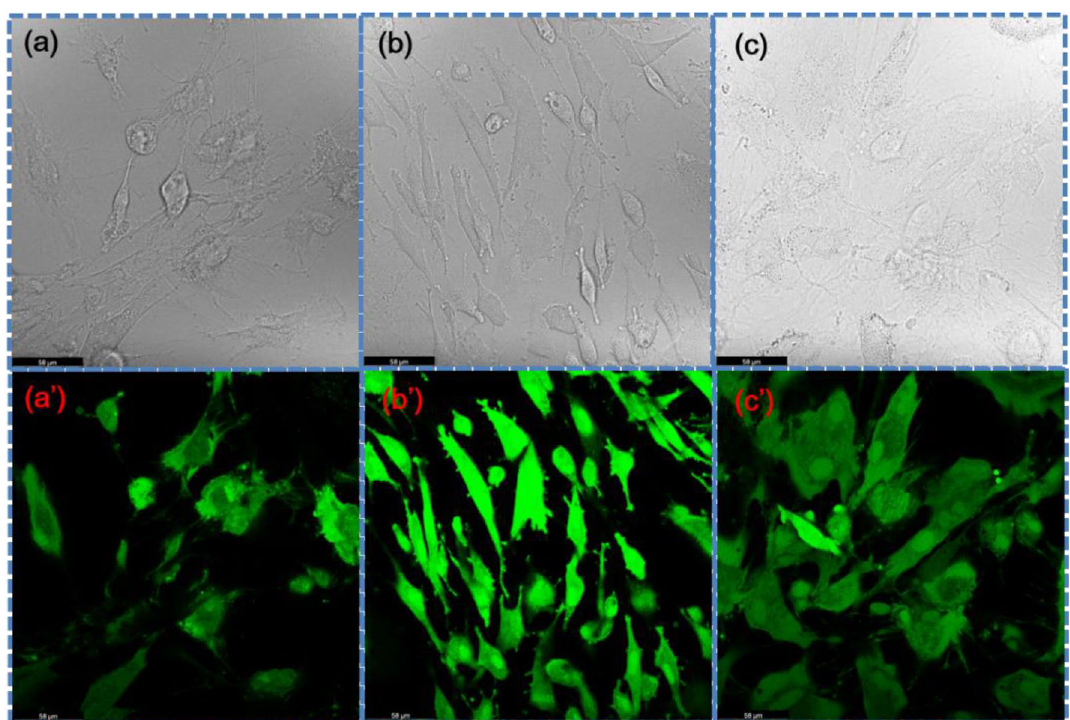
Figure 7. Confocal microscopic images of rabbit chondrocyte viability study staining ( a,a ʹ ) with live assay kit with scaffold, ( b,b ʹ ) with live assay kit immersed in SGNR, and ( c,c ʹ ) with live assay kit immersed in SGNR and treated with NIR